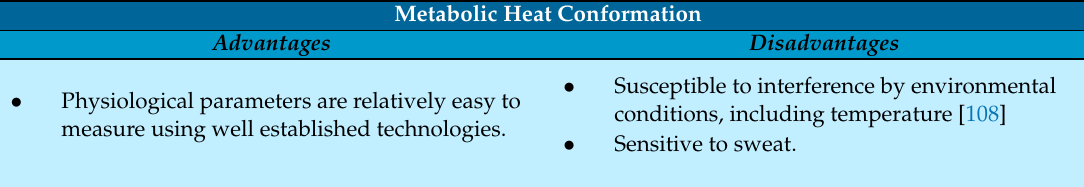
Table 15. Advantages and disadvantages of MHC.